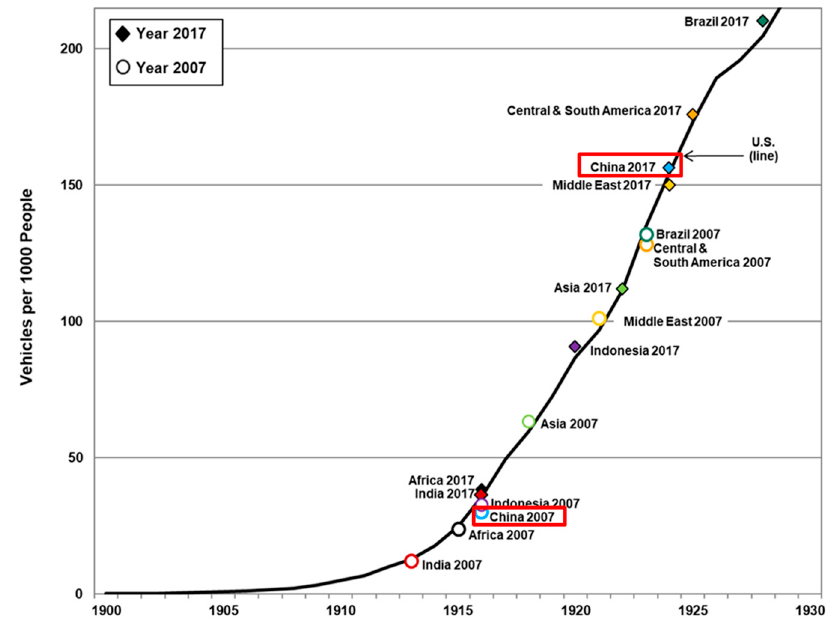
Figure 1. Vehicles per one thousand people in selected countries/regions, 2007 to 2017 (black curve shows the vehicles per 1000 people in the U.S. in 1900–1930, Reproduced/Adapted with permission from Stacy C. Davis, and Robert G. Boundy, Transportation Energy Data Book: Edition 37; published by Oak Ridge National Laboratory, 2019 ( https://tedb.ornl.ogv).) [10].